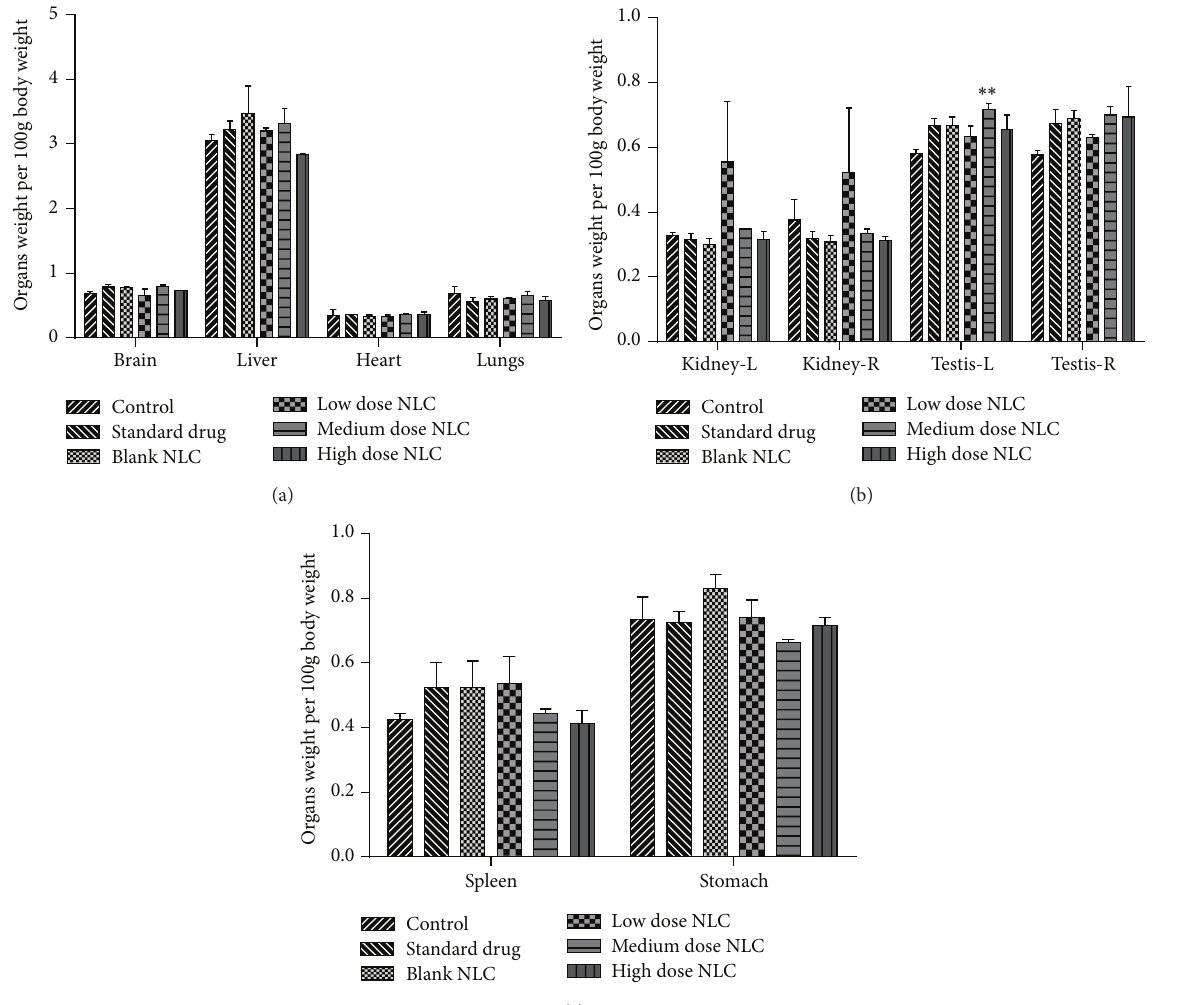
Figure 2: (a, b, and c) Organ weight of male rats treated with NLCs formulation. All the values are represented as mean ± SEM and 𝑛 = 5 . ∗∗ 𝑝 < 0.01 . Kidney-R: right kidney, Kidney-L: left kidney, Testis-R: right testis, and Testis-L: left testis.